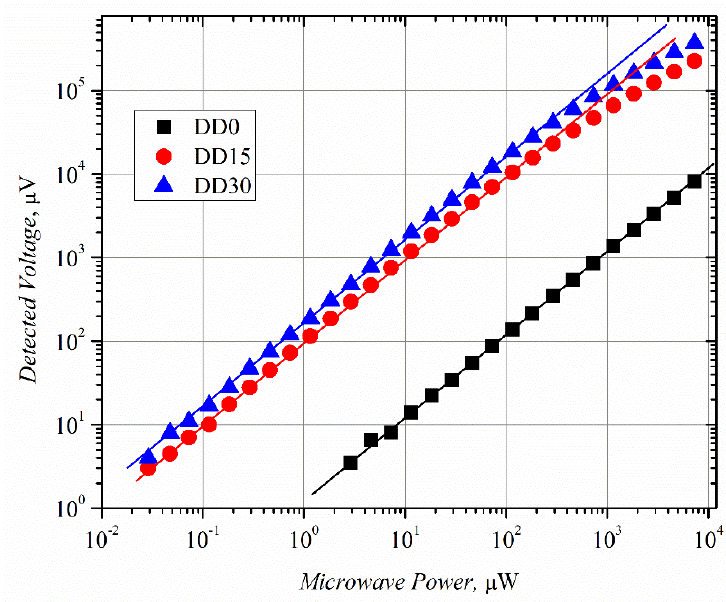
Figure 4. Voltage–power characteristics of the planar microwave diodes measured under white-light illumination at f = 30 GHz frequency. Lines are guides for the eye of linear dependence.